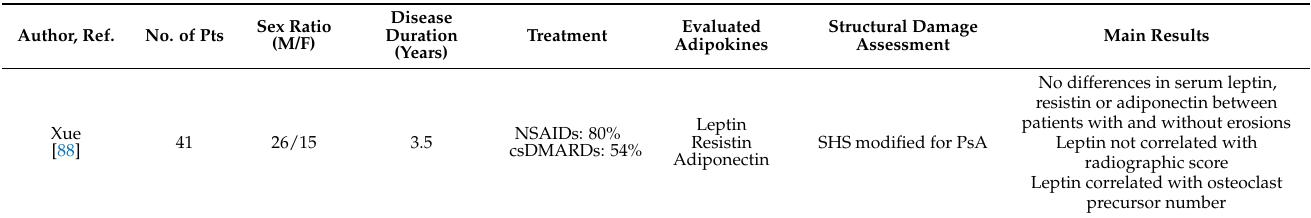
Table 3. Relationships between adipokines and radiographic damage in psoriatic